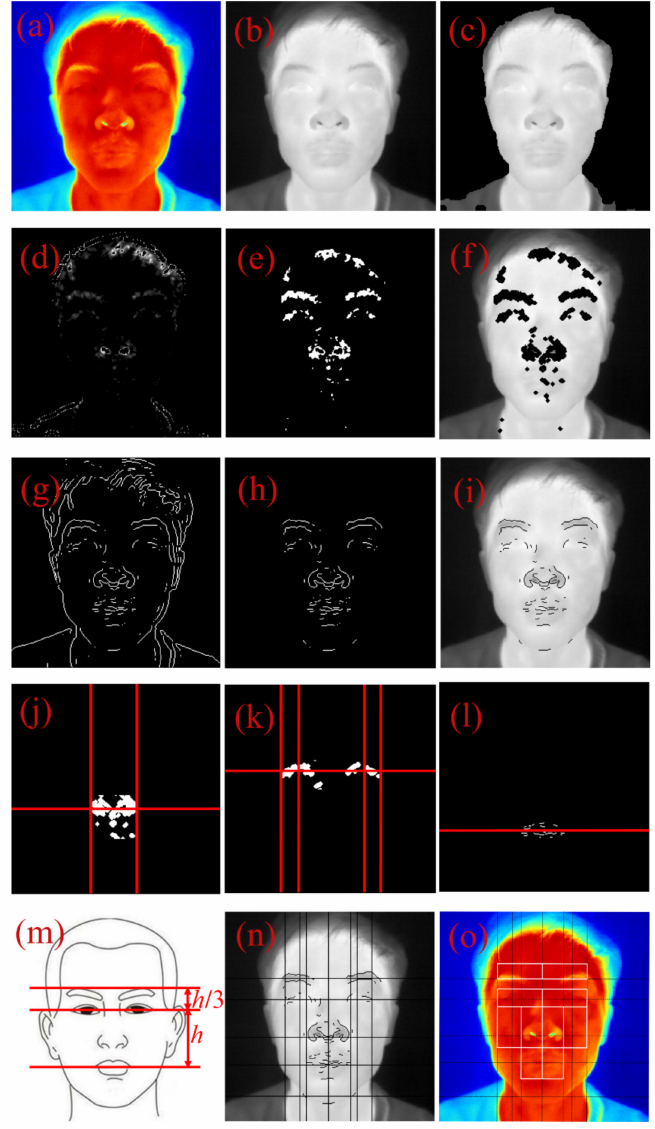
Figure 3. General process of automatic segmentation of facial ROIs. ( a ) Raw thermal image; ( b ) Gray processing; ( c ) Face segmentation; ( d ) Corner detection; ( e ) Image Erosion and Dilation; ( f ) Corner features; ( g ) Edge detection; ( h ) Image Erosion; ( i ) Edge features; ( j ) Gray projection of the nose; ( k ) Gray projection of the eye; ( l ) Gray projection of the mouth; ( m ) Anthropometry; ( n ) Eyebrow location; ( o ) ROI